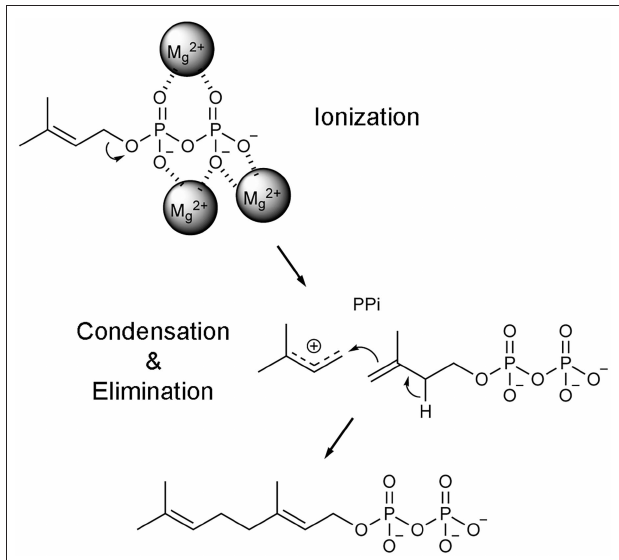
FIGURE 4 | Catalytic mechanism of FPPS reaction. Only the first catalytic cycle (i.e., the condensation of DMAPP and IPP to produce GPP) is represented for simplicity. In the subsequent cycle, GPP is condensed with another unit of IPP to produce the final product